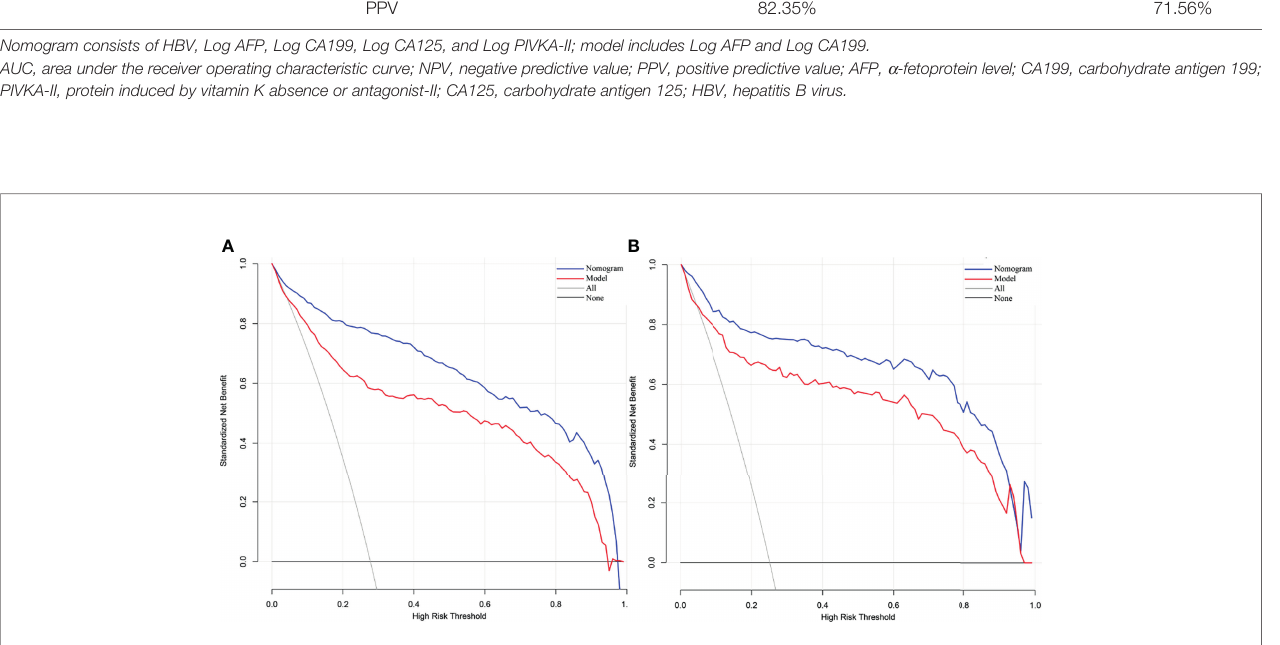
FIGURE 4 | Decision curve analysis of our nomogram and model from development cohort (A) and validation cohort (B) . The net bene fi t versus the risk threshold probability is plotted. The x- and y-axes show the risk threshold probability and net bene fi t, respectively. A model is only clinically useful if it has a higher net bene fi t than the default treat-all and treat-none. It is clear from the graph that both the nomogram and model are superior to either treat-all or none strategy. Besides that, using the nomogram to distinguish ICC from HCC may get more bene fi t compared with